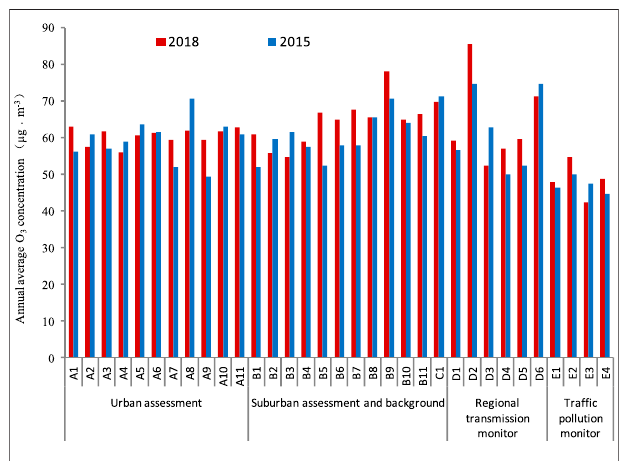
FIGURE 9 | Comparisons of annual averaged O 3 concentration at 33 stations between 2015 and 2018.